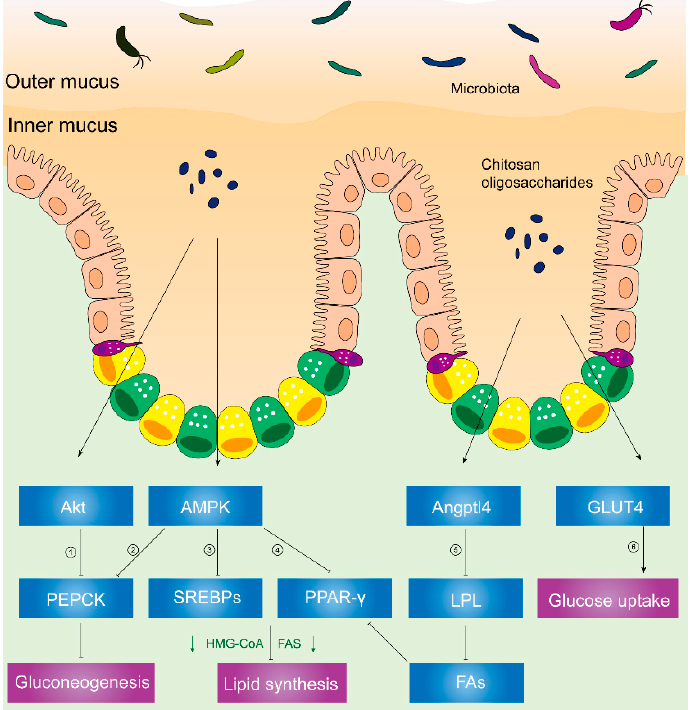
Figure 2. Chitosan and its derivatives mediate lipid and glucose metabolisms. ① Phosphorylated Akt can activate PEPCK, a rate-limiting enzyme in gluconeogenesis, and the conversion of noncarbohydrates to glucose. ② Activated AMPK can phosphorylate PEPCK. ③ Phosphorylated AMPK can inhibit expression of SREBPs, leading to inhibited HMG-CoA, FAS, etc. HMG-CoA is responsible for synthesis of cholesterol. FAS acts on synthesizing fatty acids. ④ Activated AMPK inhibits PPAR- γ , causing suppressed HMG-CoA, FAS, etc. ⑤ Upregulated Angptl4 inhibits activity of LPL, leading to less fatty acids released from VLDL and chylomicrons. Reduced fatty acids inhibit PPAR- γ , suppressing HMG-CoA, FAS, etc. ⑥ Translocation of GLUT4 from cytoplasm to skeletal muscle cell membranes can increase glucose uptake and decrease plasma glucose levels.